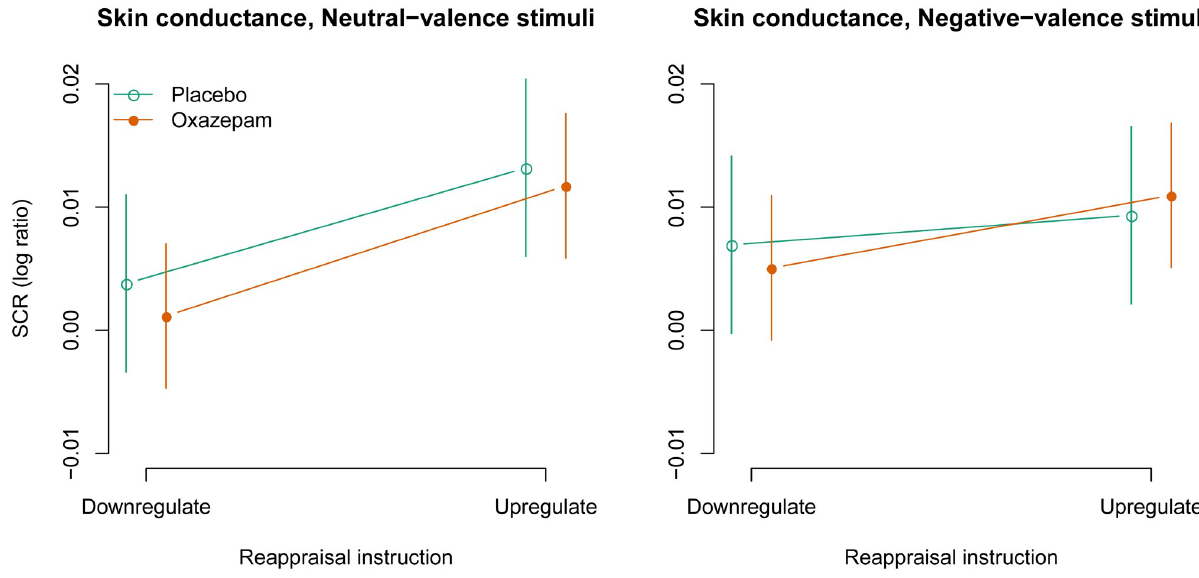
Fig 4. Skin conductance: Model estimates with 95% confidence intervals.